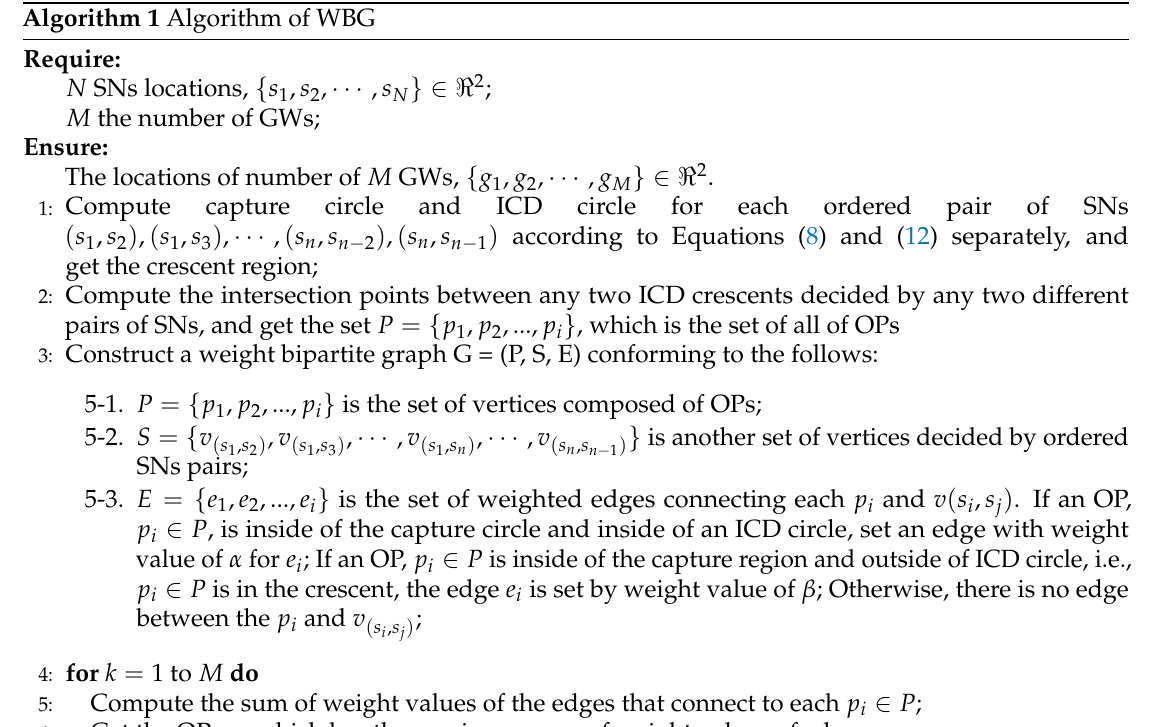
Algorithm 1 Algorithm of